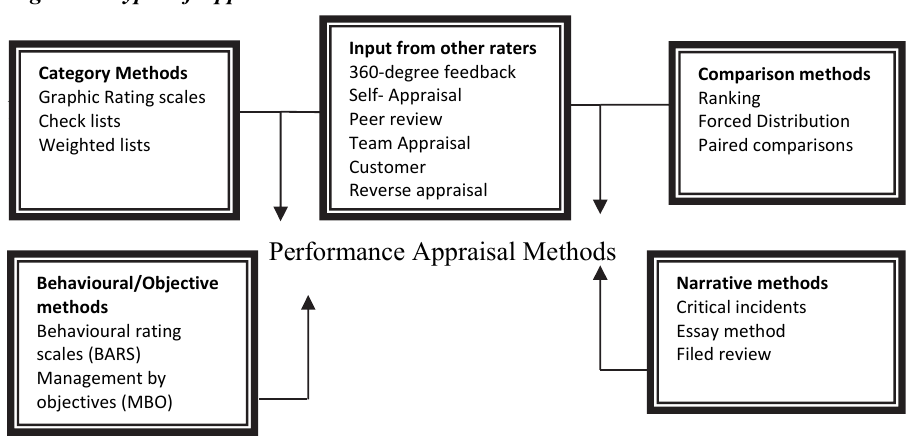
Figure 4: Types of Appraisal